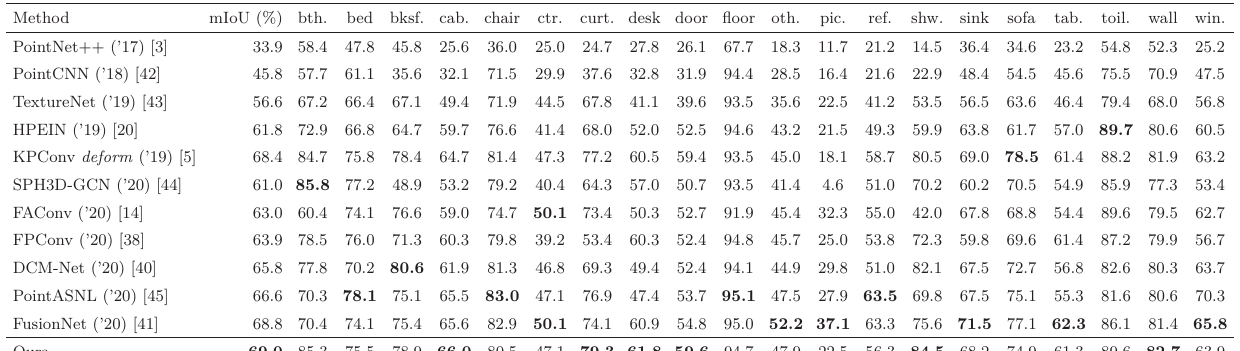
Table 3 Semantic segmentation results on ScanNet v2